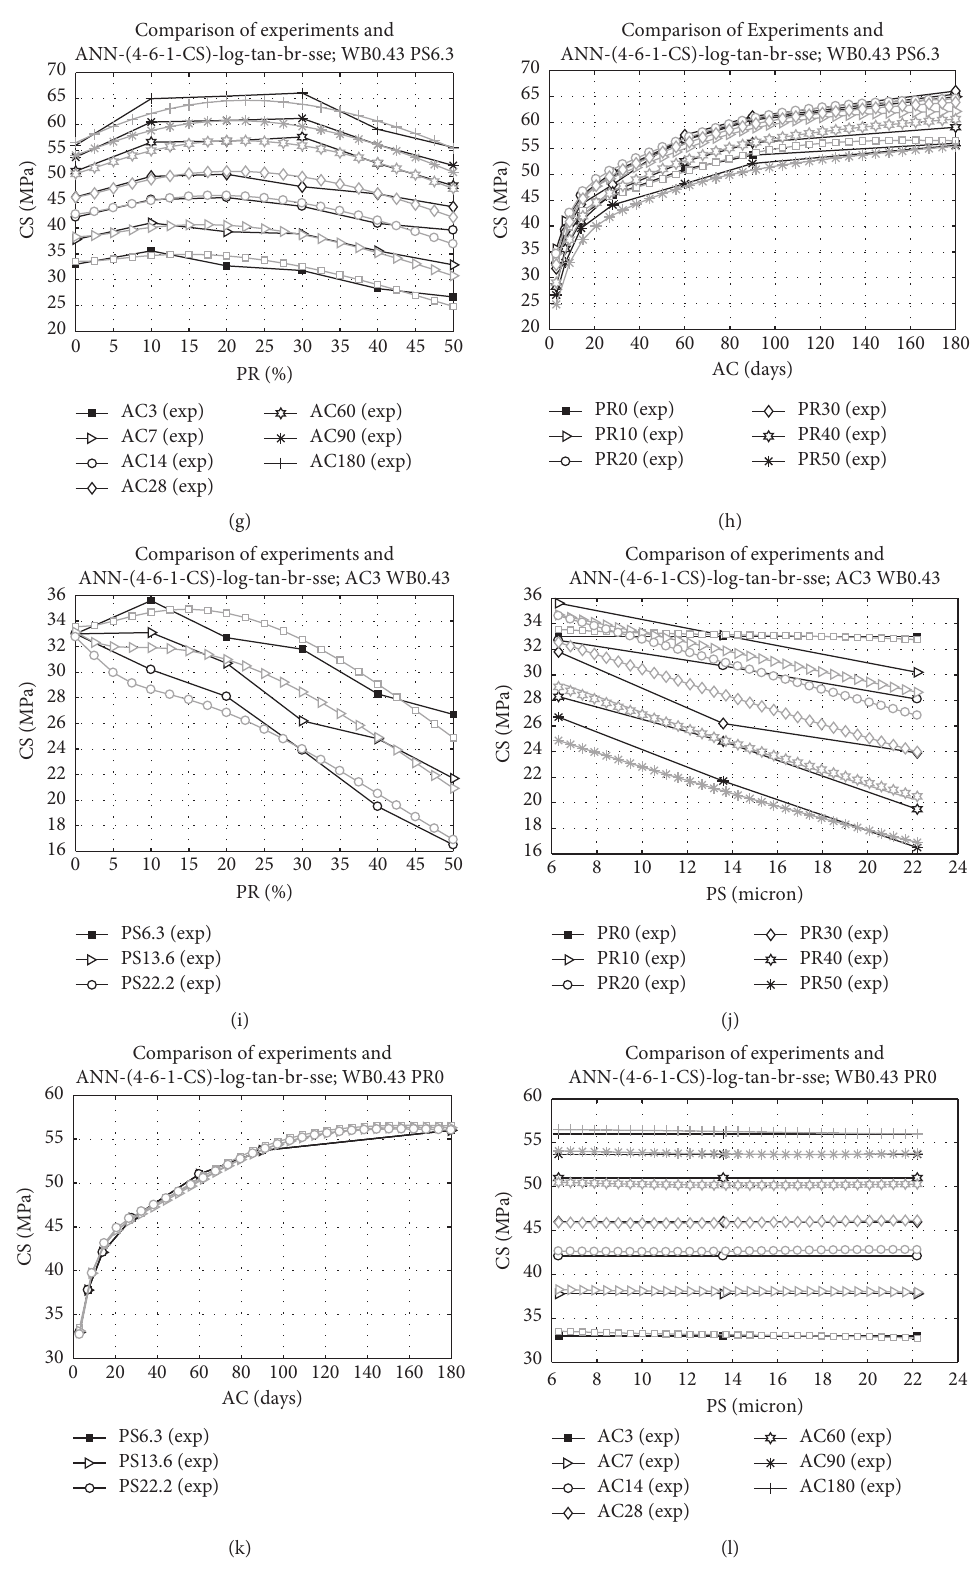
Figure 6: The 2D plots of comparison between experimental results and predictive results of the optimal ANN models with the factor parameter of WB � 0.43, PR � 0, PS � 6.3, and AC �